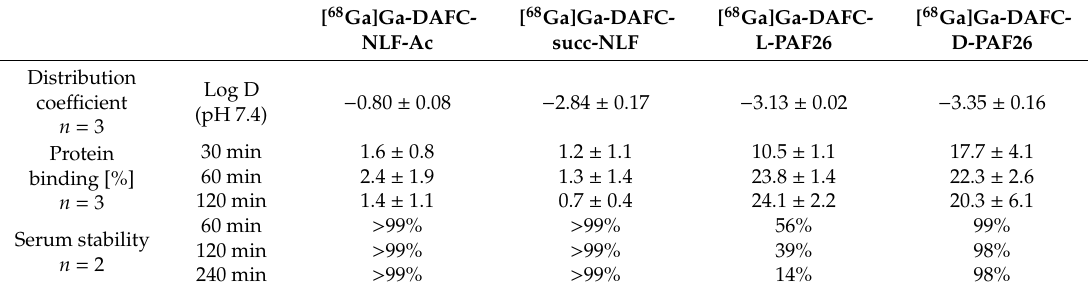
Table 1. Distribution coe ffi cient, protein binding and serum stability of siderophore compounds radiolabelled with gallium-68. Protein binding is displayed as percentage eluting from size exclusion column (Microspin G-50) after serum incubation, values of serum stability reflect the percentage of intact radiolabelled